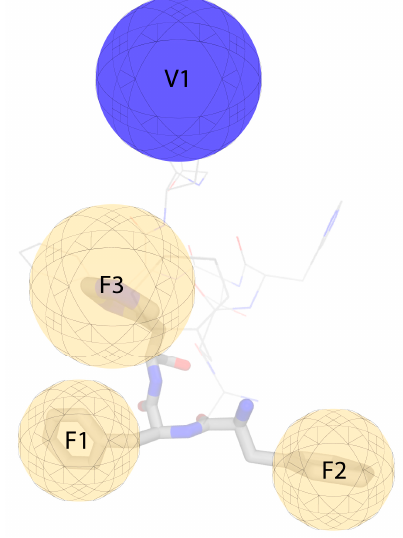
Figure 6. Structures of cyclo(91–99)(Ala 96 )MBP 87–99 , cyclo(87–99)(Ala 91 , 96 )MBP 87–99 and cyclo(87–99)(Arg 91 , Ala 96 )MBP 87–99 .